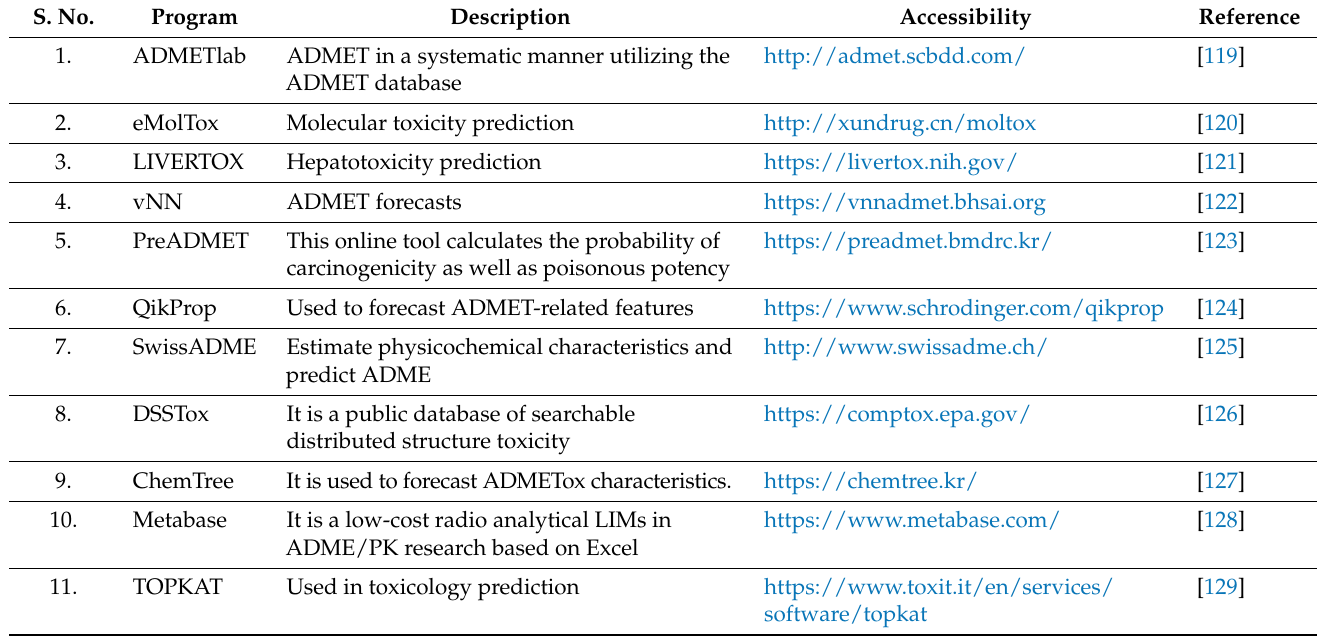
Table 5. Summary of the most usually recognized ADME analysis tools used in the computational drug design